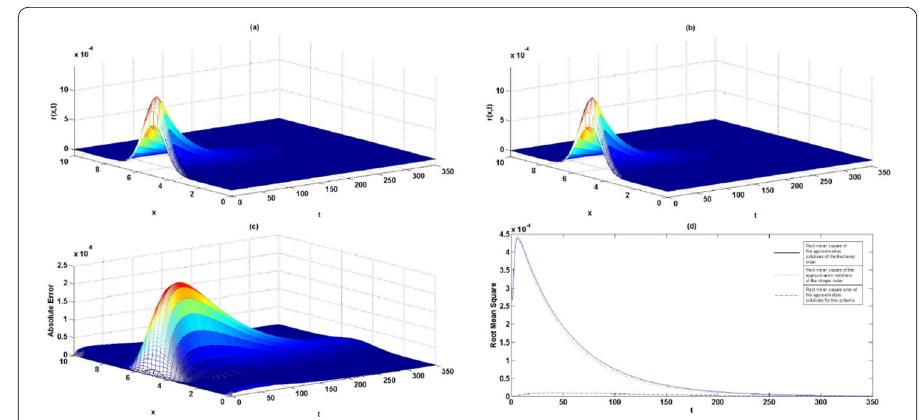
Figure 1 ( a ) The approximation solution of the fractional order differential equation. ( b ) The approximation solution of the integer order differential equation. ( c ) The absolute error between the approximation solutions of the fractional order with the integer order differential equation. ( d ) The root mean square error between the approximation solutions of the fractional order with the integer order differential equation